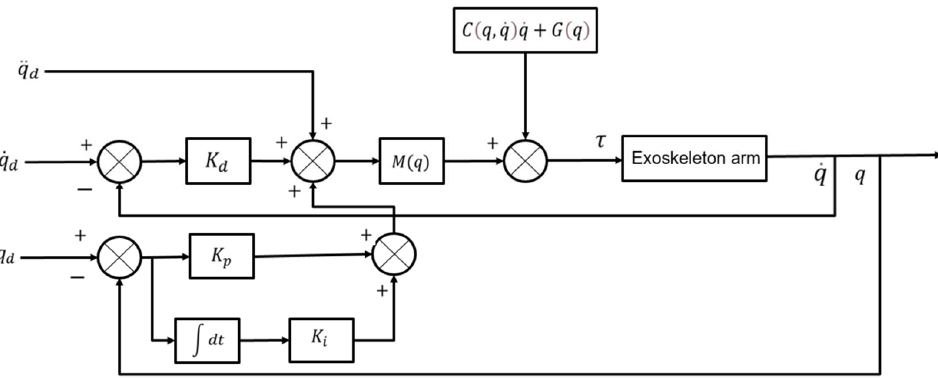
Figure 13. Block diagram that describes the implementation of PID-CTC on SAMA exoskeleton.